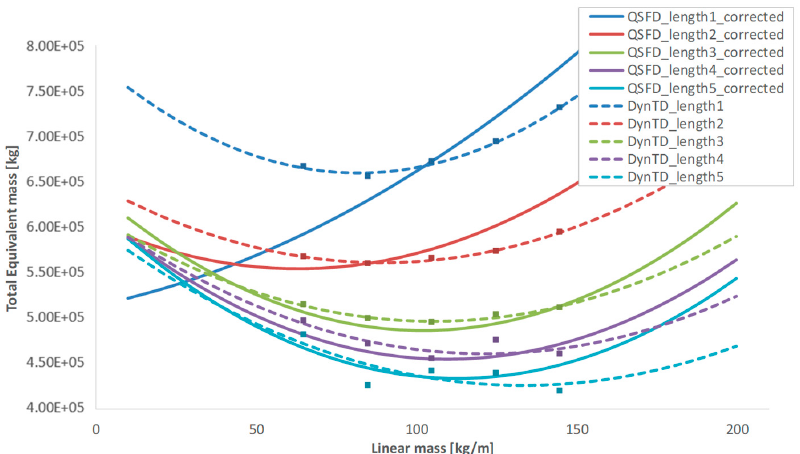
Figure 18. Cost optimization of the mooring system. Total equivalent mass is the sum of 1/3